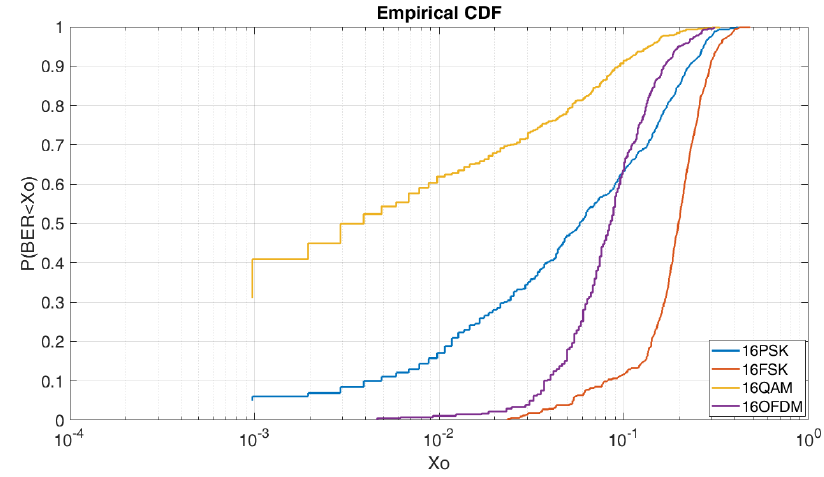
Figure 10. BER vs. E b / N 0 = 5 dB M = 16.